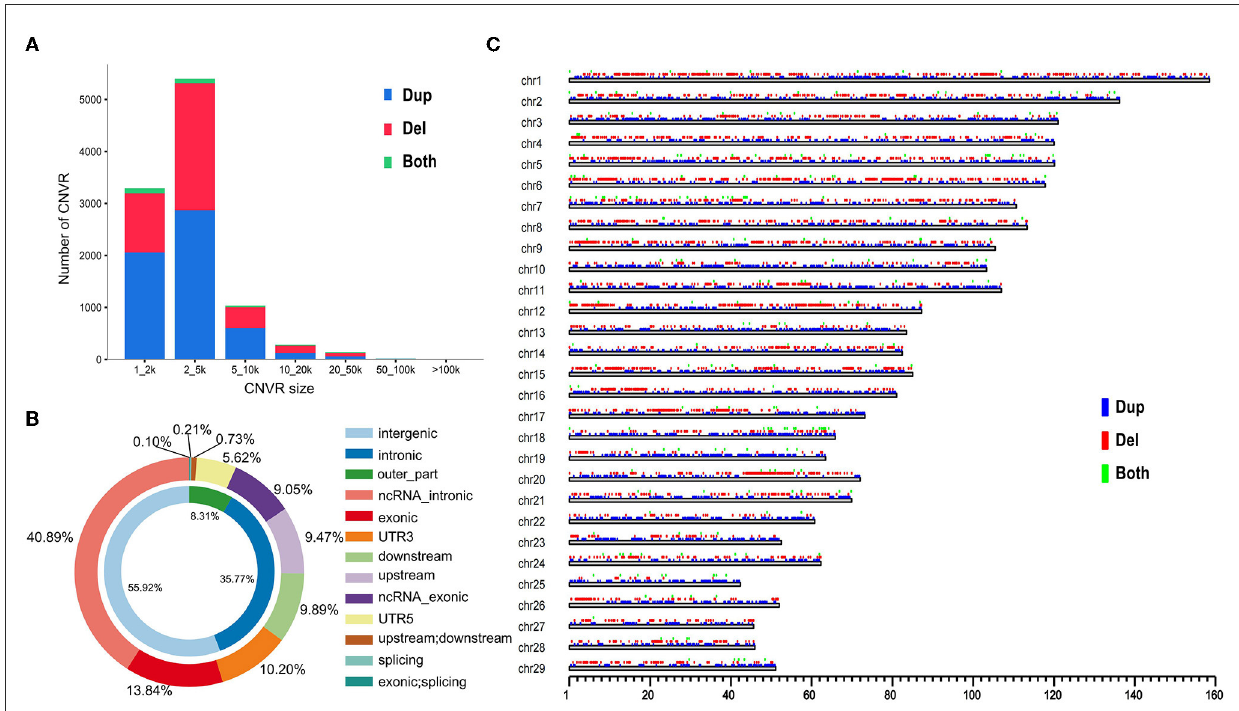
FIGURE1 Genomic diversity and distribution of CNVRs. (A) The number of the detected CNVR. (B) Annotation of CNVRs with various genomic features. The inner circle indicates the intronic region, intergenic region, and the remaining set of functional regions (outer_part). The outer circle includes ncRNA intronic; exonic; UTR3; downstream; upstream; ncRNA exonic; UTR6; splicing; upstream and downstream; exonic and splicing. (C) The autosomal distribution of CNVRs. The location with different colors represent duplication (blue), deletion (red), and both duplication and deletion